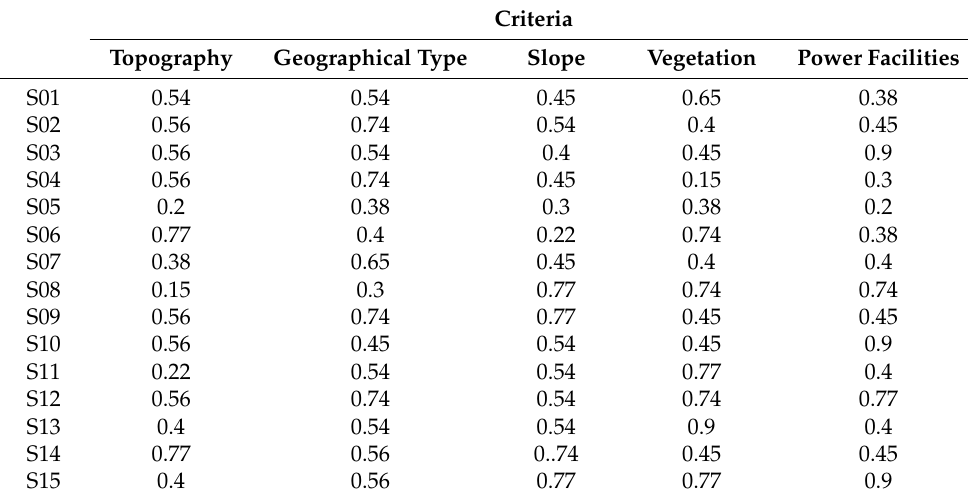
Table 11. Crisp values of candidate shelters.